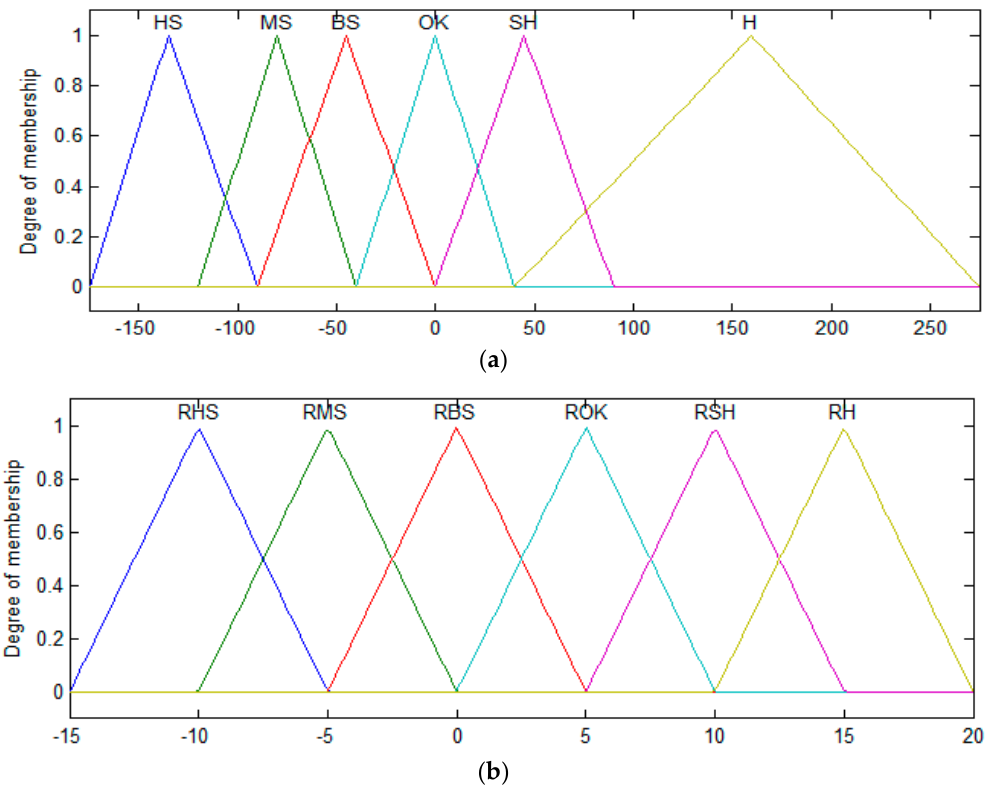
Figure 12. Membership functions for illumination. ( a ) Input (cid:1857) (cid:1838) , ( b ) output RPL.